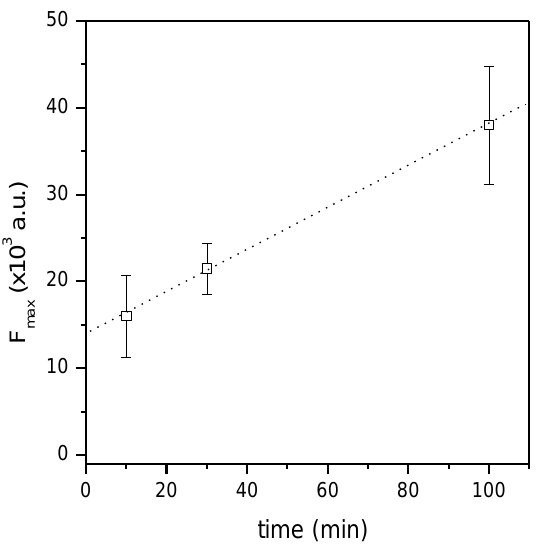
Figure 8. Adsorption of synthetic microRNA on Chip B. The titration of efficiency in capturing microRNAs with time is measured by fluxing miR-1246-TAMRA dissolved in human plasma added with lysis buffer at constant concentration. Fluorescence signal is the mean of maximum signal measured in consecutive coils, while error bars refer to standard error. A linear fit is also shown (dotted line; R = 0.999).